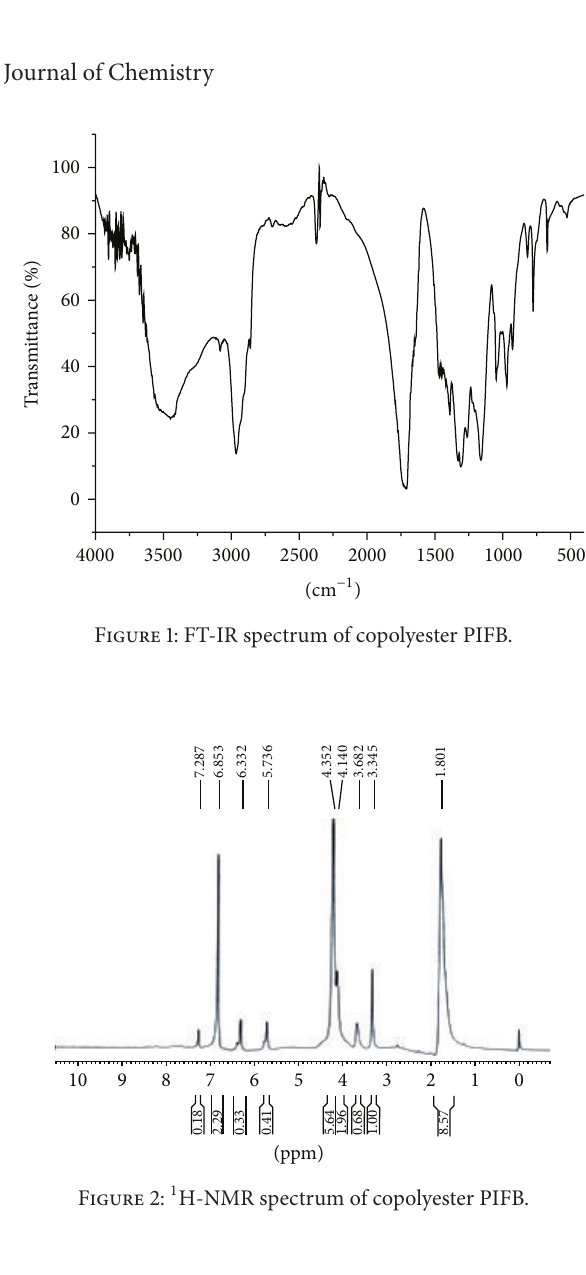
bovine serum (FBS), penicillin (100 𝜇 g/mL) and strepto-